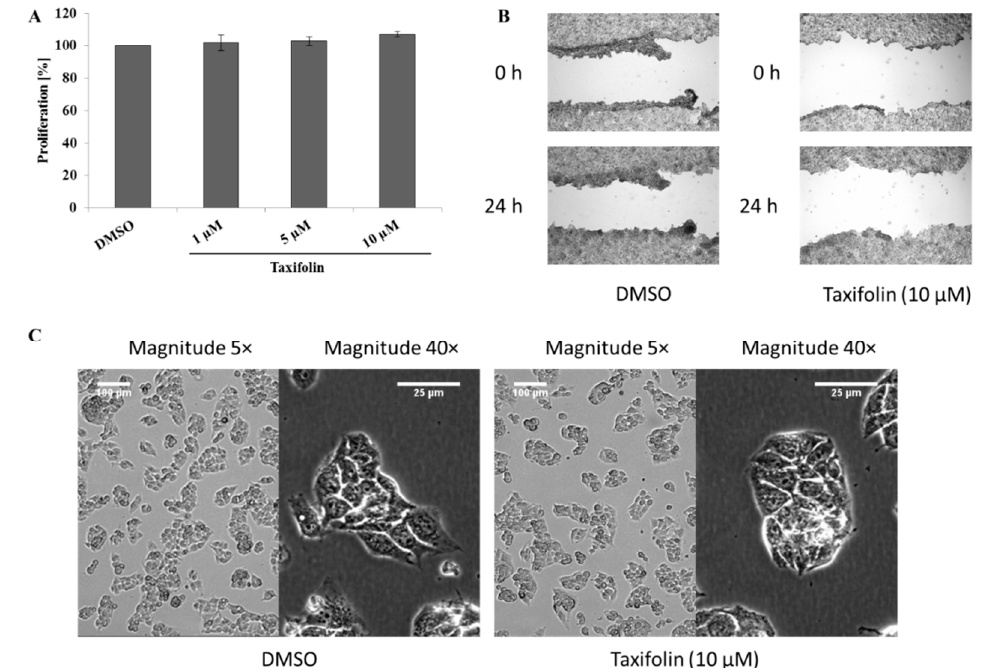
Figure A2. Modulation of Hep G2 proliferation, wound healing, and vimentin expression by taxifo- lin. Panel ( A ): Hep G2 cells were treated with taxifolin in xCELLigence system for 24 h. Differences in the doubling time were evaluated and normalized to negative control (DMSO). Panel ( B ): Hep G2 cells were seeded and incubated with 10 µM taxifolin or negative control containing DMSO. Wound healing was evaluated by bright field mode of Zeiss AxiovertC microscope after 24 h of incubation. Objective with magnitude 2.5× was used during the experiment. Panel ( C ): Hep G2 cells were seeded and incubated with 10 µM taxifolin or negative control (contains only DMSO). Mor- phological changes were evaluated by bright field microscope after 24 h of incubation with objective magnitude 5× or 40×.